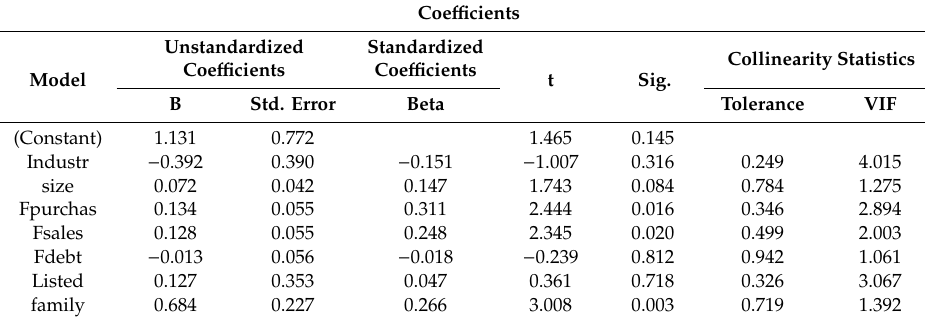
Table A1. The Results of the Multicollinearity analysis showing the coe ffi cient and VIF for each variable in the study.